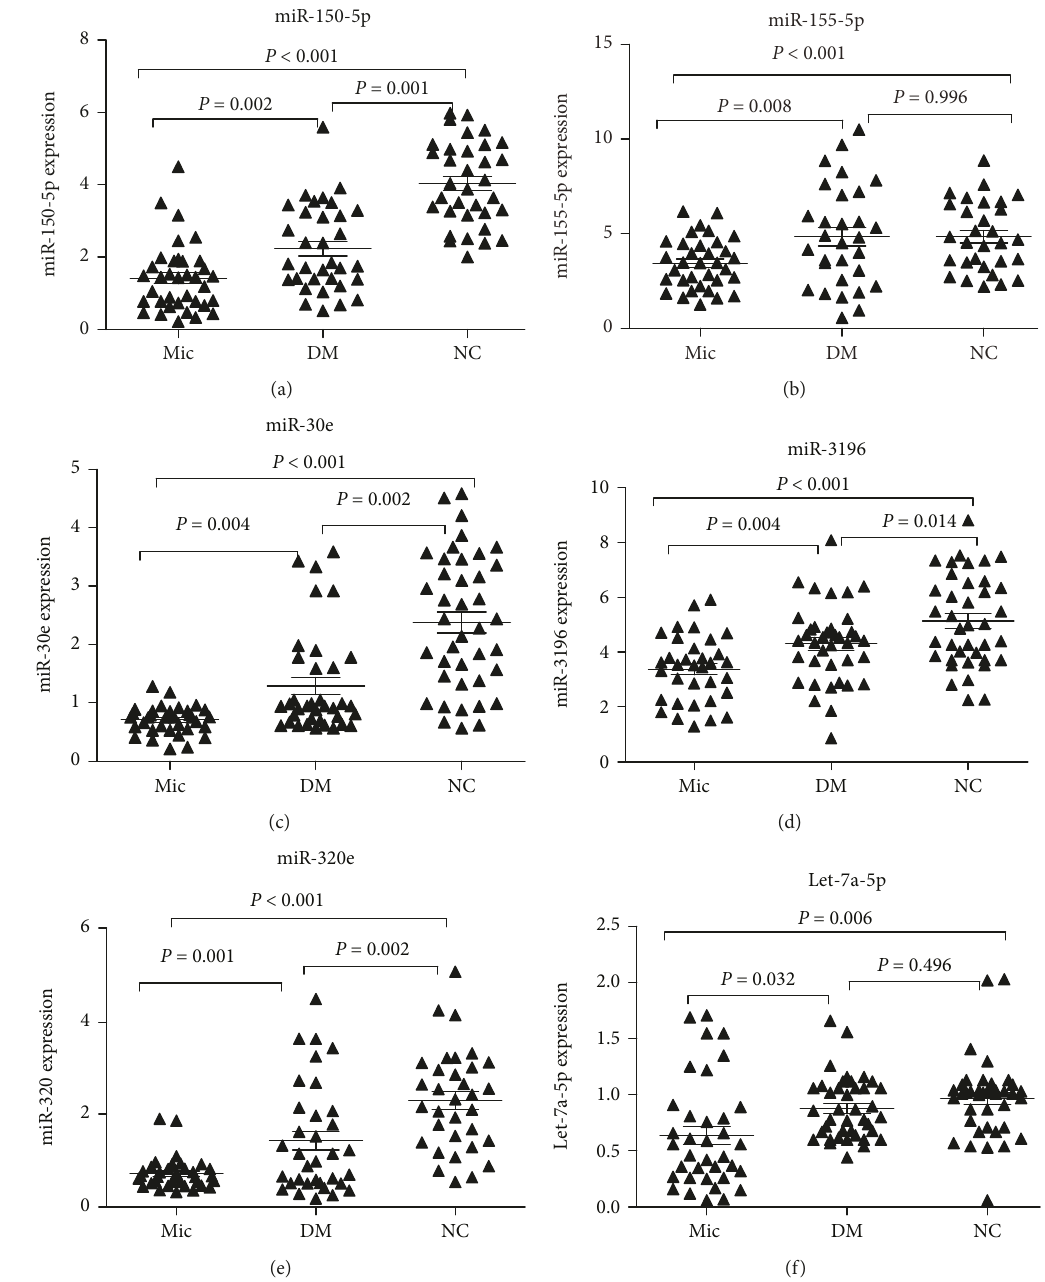
Figure 2: Analysis of the relative transcription levels of plasma miRNAs using the nonparametric Mann-Whitney U -test. The expression of miR-155-5p (a), miR-150-5p (b), miR-30e (c), miR-3196 (d), miR-320e (e), and let-7a-5p (f) was determined by quantitative real-time PCR. P < 0 05 and P < 0 001 indicate statistical signi fi cance and highly statistical signi fi cance, respectively. Mic: diabetes mellitus with microalbuminuria ( n = 36 ); DM: diabetes mellitus with normoalbuminuria ( n = 40 ); NC: normal controls ( n = 40 ). The error bars are presented as standard error of the mean